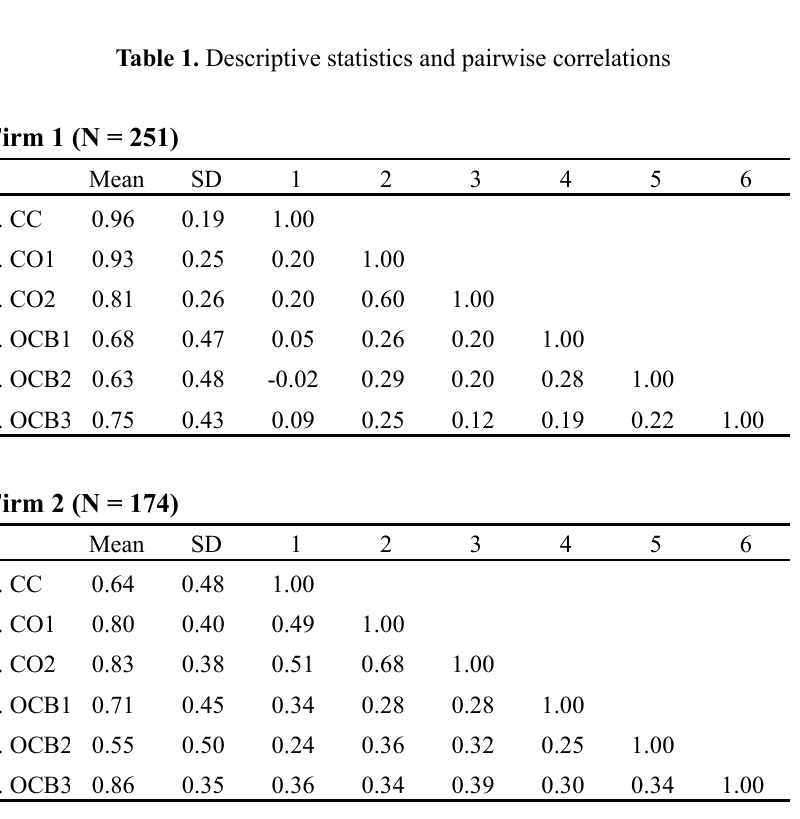
Table 1. Descriptive statistics and pairwise